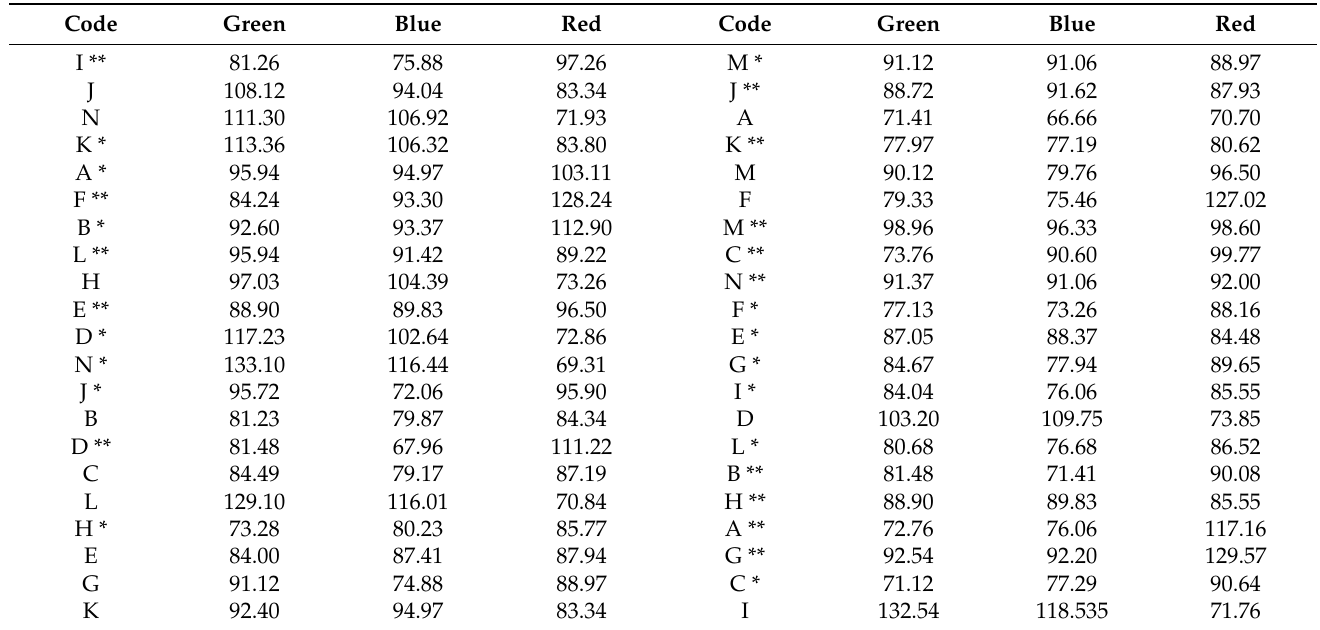
Table 3. Summary of colour content means for each picture.